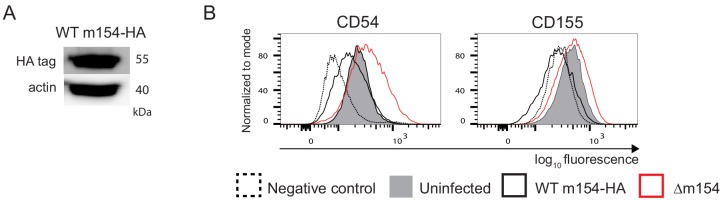
Surface expression of CD54 and CD155 is downregulated in infection with MCMV WT m154-HA.Two residues of aspartic acid in the cytoplasmic tail of WT m154 were substituted with two alanines (AA) to create the MCMV recombinant m154-DDAA virus, with the HA tag added to the end of the m154 protein. In the case of the WT m154-HA virus, the gene for the m154 protein is not mutated, only the HA tag is added to the end of the gene. (A) Western blot detection of m154-HA. (B) Flow cytometry analysis of surface molecules of DC2.4 cells (CD54) and B12 cells (CD155) infected with 3 PFU/cell for 40 h. Data are representative of 2 independent experiments.